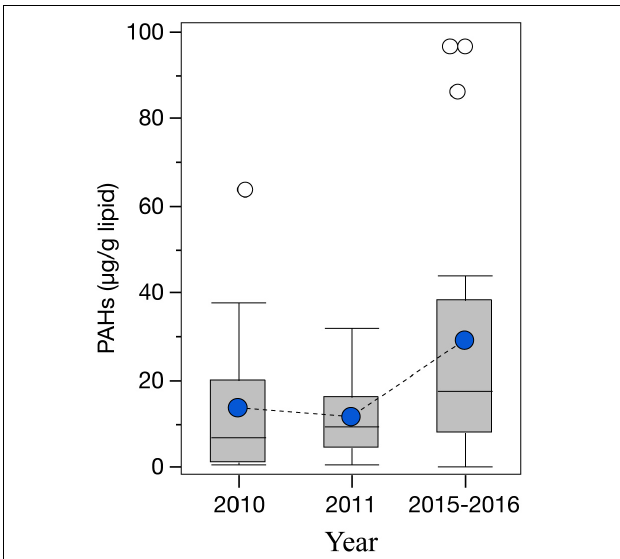
FIGURE 5 | Temporal variability of PAH concentrations in the mantle tissue of deep-sea cephalopods (species combined) collected in the northern Gulf of Mexico. Sampling years: pre-spill: 2010, post-spill: 2011, and long-term: 2015–2016. PAHs refer to the sum of 2–6 ring including alkylated homologs. Graph shows shaded boxes as the interquartile ranges, with horizontal lines indicating median values and whiskers representing 10th and 90th percentile. Blue circles denote mean values, and white circles denote outliers.